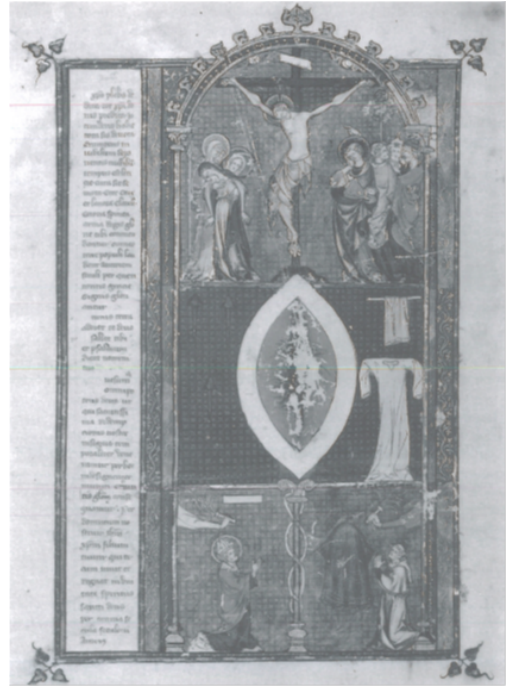
Arma Christi , MS Fr. 574 fol. 140v, 132, illuminated manuscript. Bibliothèque nationale de France,